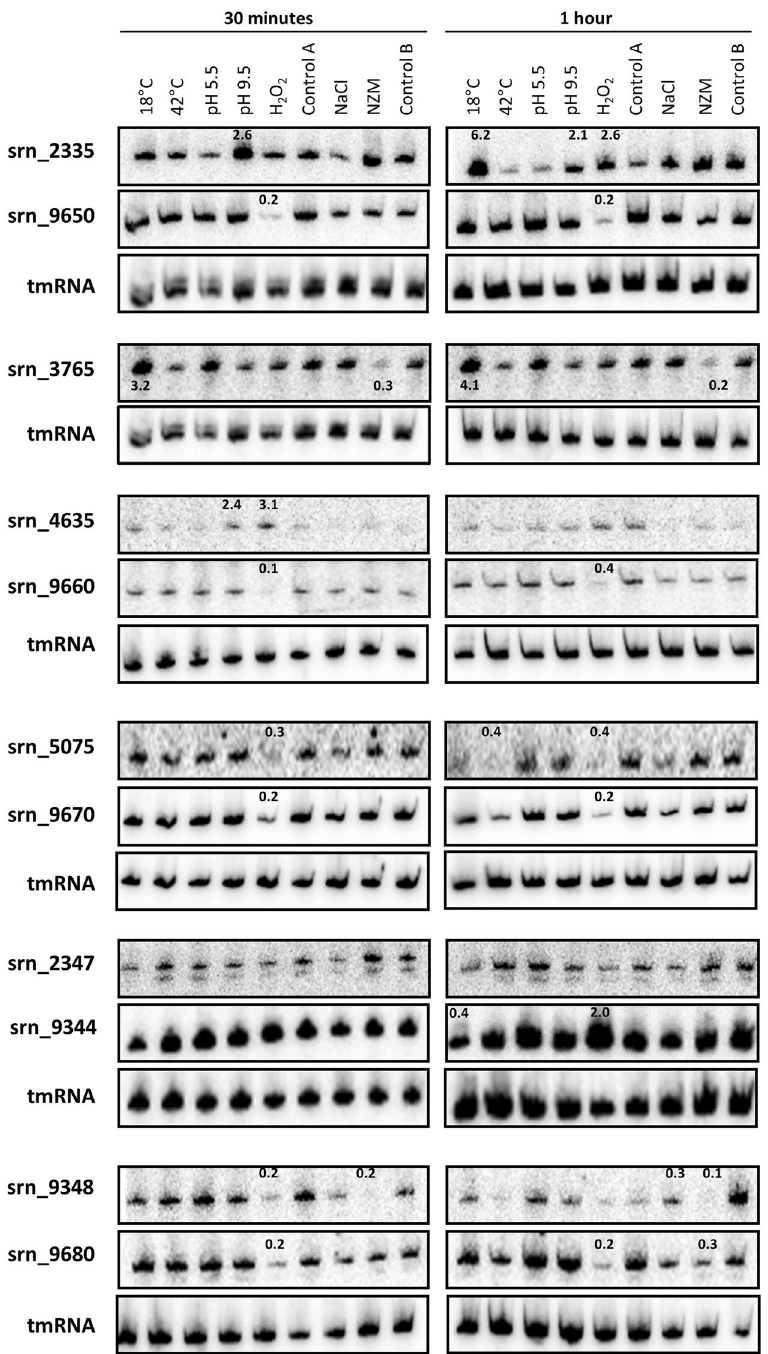
Figure 7. Expression of srns monitored under various stress. Staphylococcus aureus Newman strain was cultured in TSB broth to an OD 600nm of 2 (exponential growth phase). Stress was induced by the addition of H 2 O 2 , HCl, or NaOH, or by changing the temperature to 18 °C or 42 °C. Control A corresponds to cells maintained in TSB under normal conditions. In parallel, other cultures were centrifuged at 4500 rpm for 8 min at RT and pellets resuspended in TSB supplemented with 1 M NaCl (mimicking osmotic stress), NZM medium (emulating a stringent response), or fresh TSB (control B). The relative expression levels are indicated where appropriate, and were calculated after quantification of the dots using control A or B as calibrators. For all experiments, tmRNA was used as an internal loading control. The gels presented here were cropped for clarity